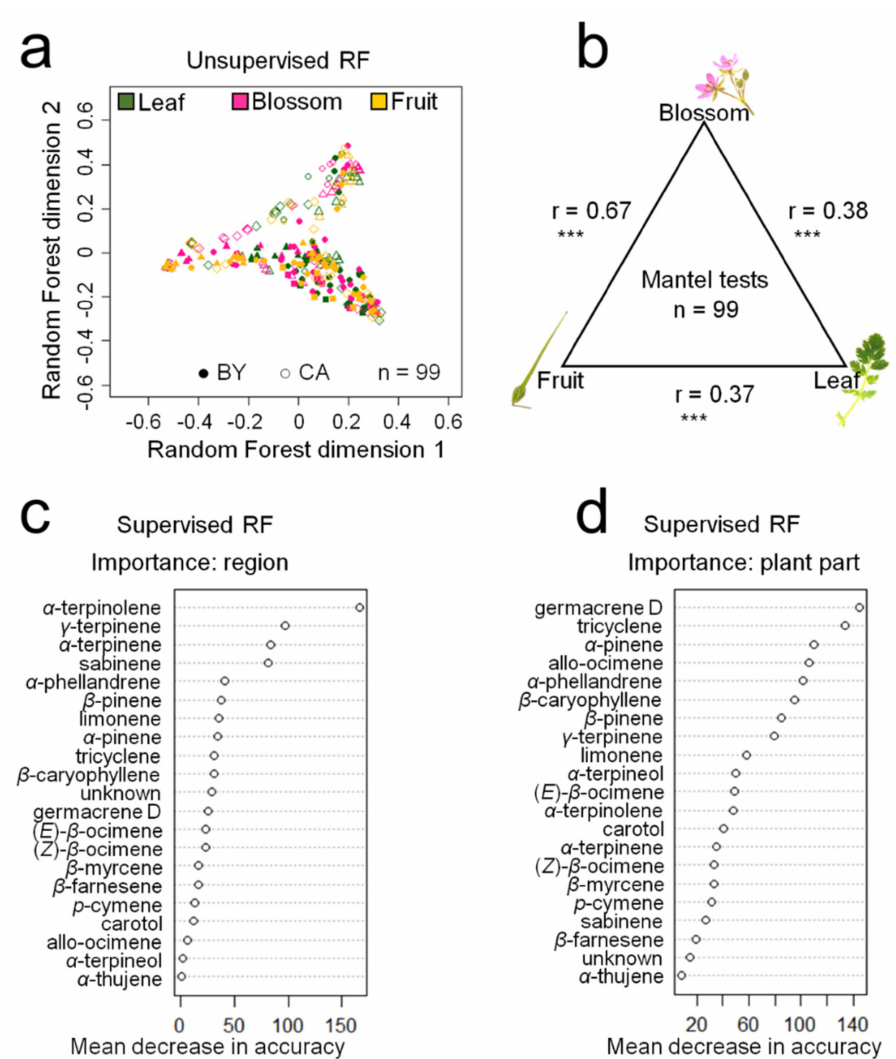
Figure 3. Random forest (RF) and Mantel statistic comparison of terpenoid profiles measured in different plant parts of Erodium cicutarium plants. Seeds originated from three Bavarian (native range) and three Californian (invasive range) populations (total n = 99 replicates per plant part). RF analyses results are displayed as point charts ( a ) with different symbols for the three different collection sites within each geographical region. The r-values and significance levels (*** p ≤ 0.001) of the Mantel tests are displayed in ( b ). Variable importance values are displayed as mean decrease in accuracy when removing the respective compounds from the analyses in supervised models using the factor “region” ( c ) or “plant part” ( d ) as explanatory